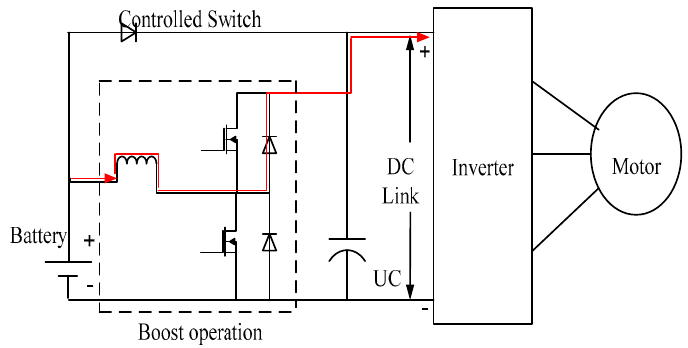
Figure 5. Slow constant-speed operation.